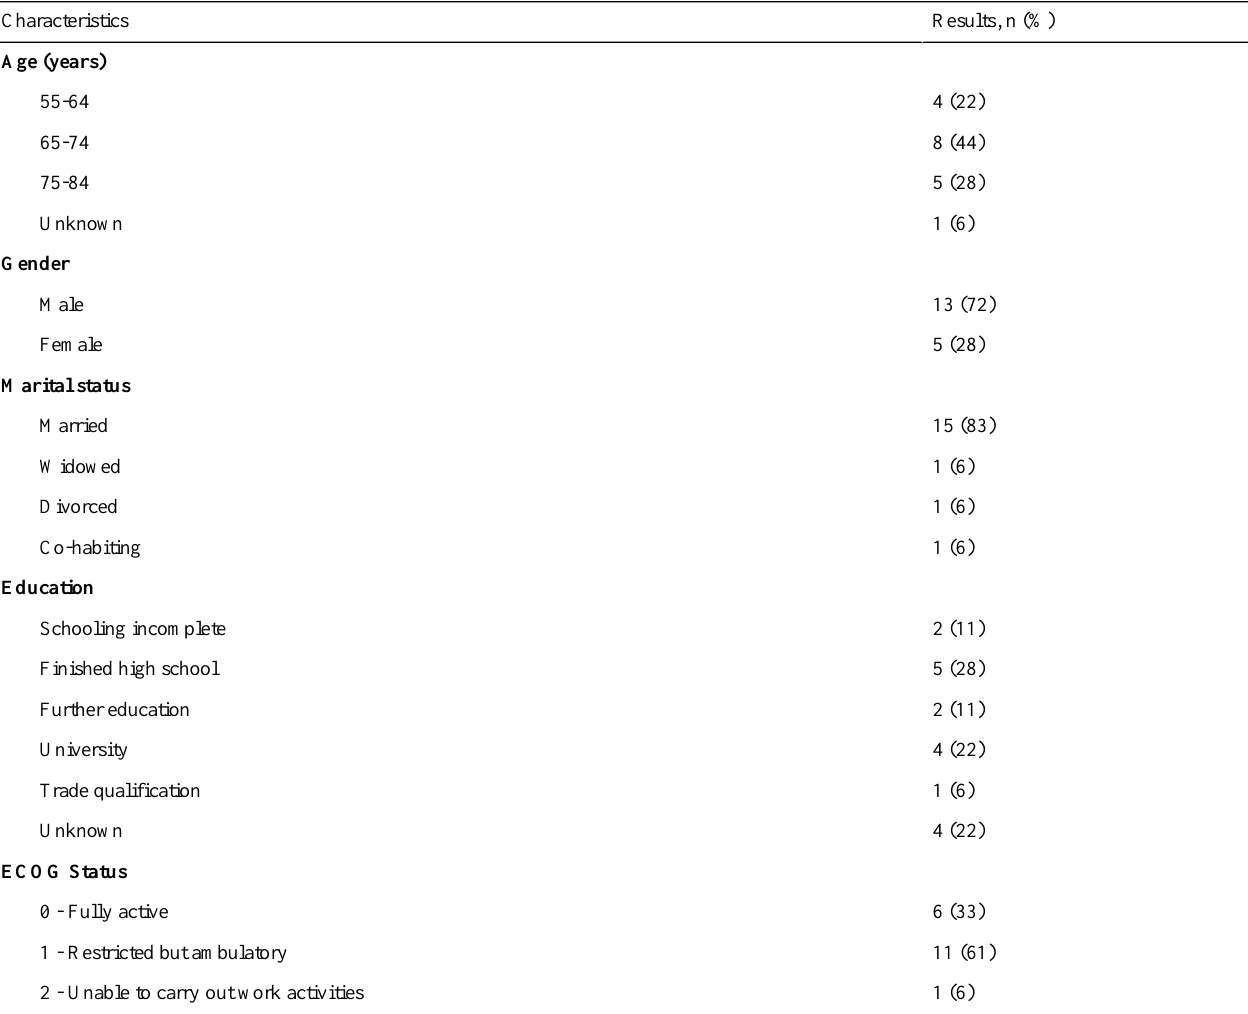
Table 1. Demographic characteristics of participants and their Eastern Cooperative Oncology Group (ECOG) status (N=18).